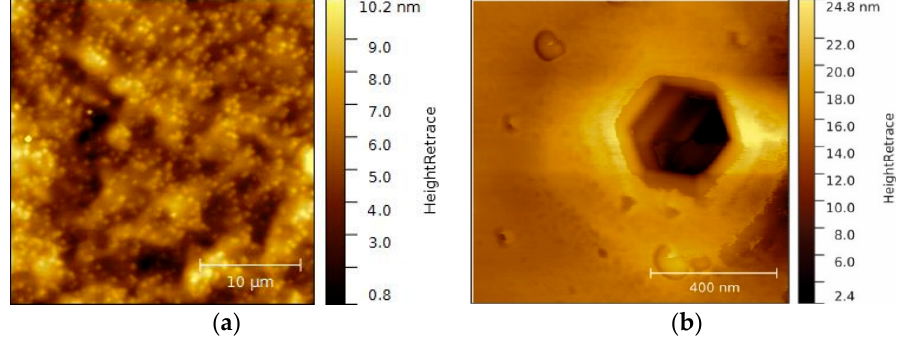
Figure 2. ( a ) A 25 × 25 µm² overview AFM image of native p-GaN on sapphire and ( b ) a higher magnification 1 × 1 µm² AFM image of an etching pit on the same surface.